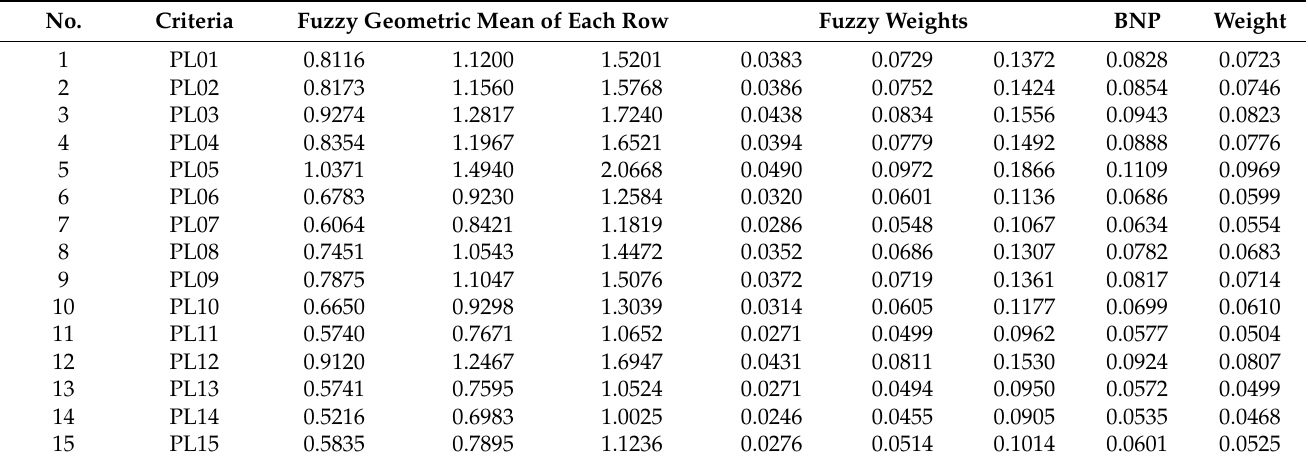
Figure 3. The FAHP model’s structure. Table 2. Weight of criteria.